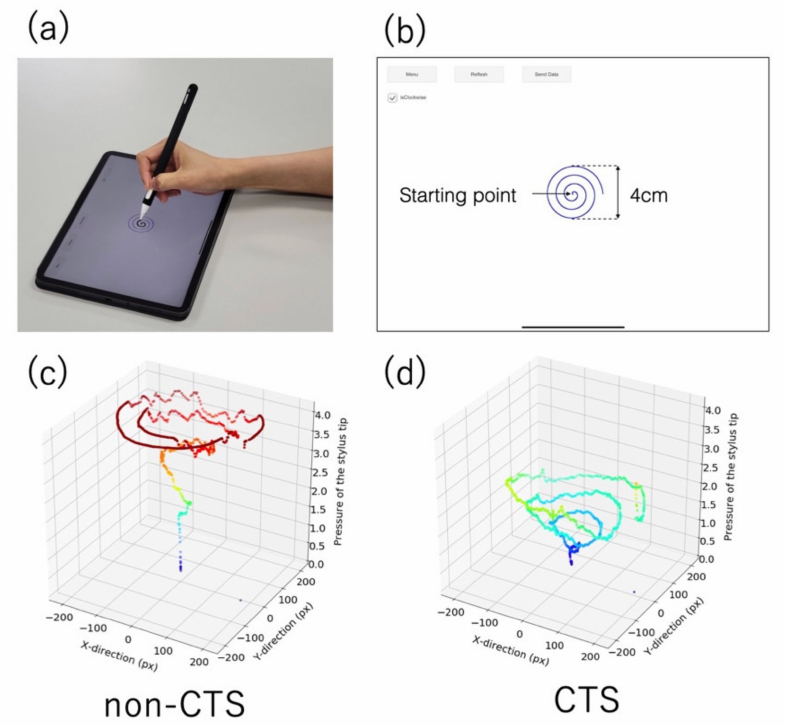
Figure 1. ( a ) A participant using the stylus on the app installed on the tablet. ( b ) The app screen. Participants drew a spiral along the blue guide spiral. The longitudinal diameter of the guide spiral was set to 4 cm to observe their manual dexterity. ( c , d ) are 3D graphs with the stylus trajectory on the xy-plane and the pressure of the stylus tip on the vertical axis drawn by non-CTS and CTS participants,